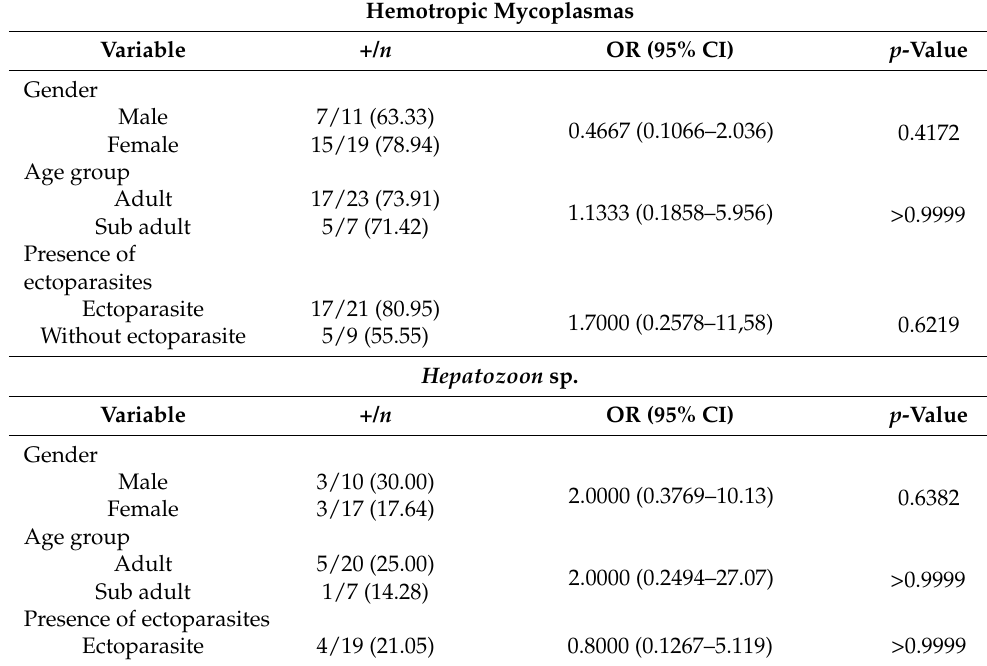
Table 3. Prevalence of hemotropic mycoplasmas and Hepatozoon sp. in D. aurita within each variable studied, Viçosa, Minas Gerais,